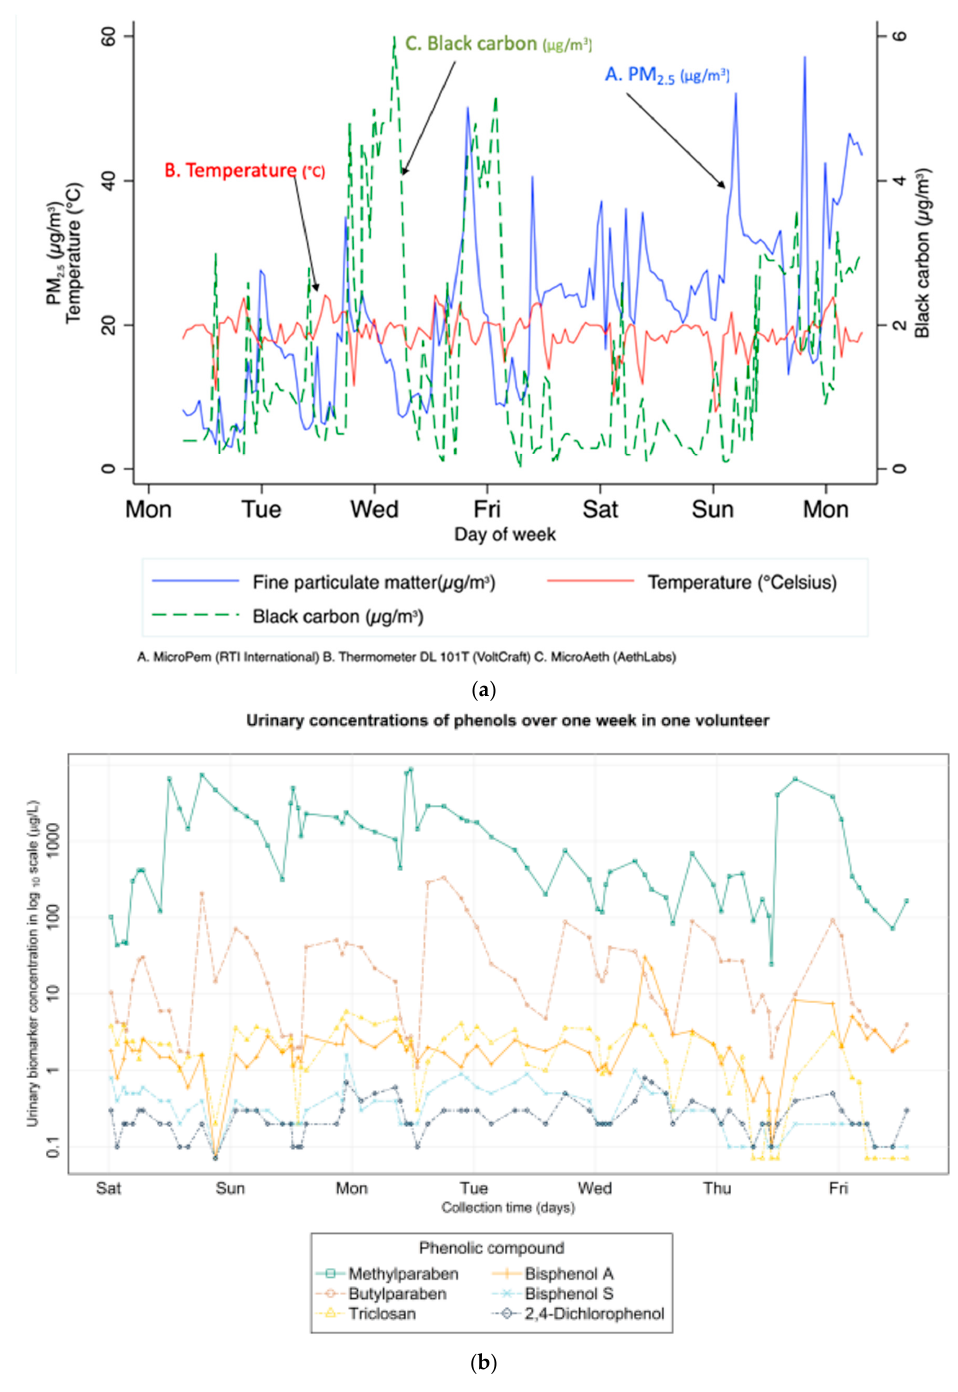
Figure 3. ( a ) Temporal variations of personal exposures in one follow-up week in one pregnant woman from SEPAGES cohort. (A) PM 2.5 concentration, µg/m 3 ; (B) temperature, °C; (C) Black carbon concentration, µg/m 3 . ( b ) Variation of urinary concentrations of phenols in urine samples collected during one week (one pregnant woman from SEPAGES-feasibility cohort; see Vernet et al. [61]).